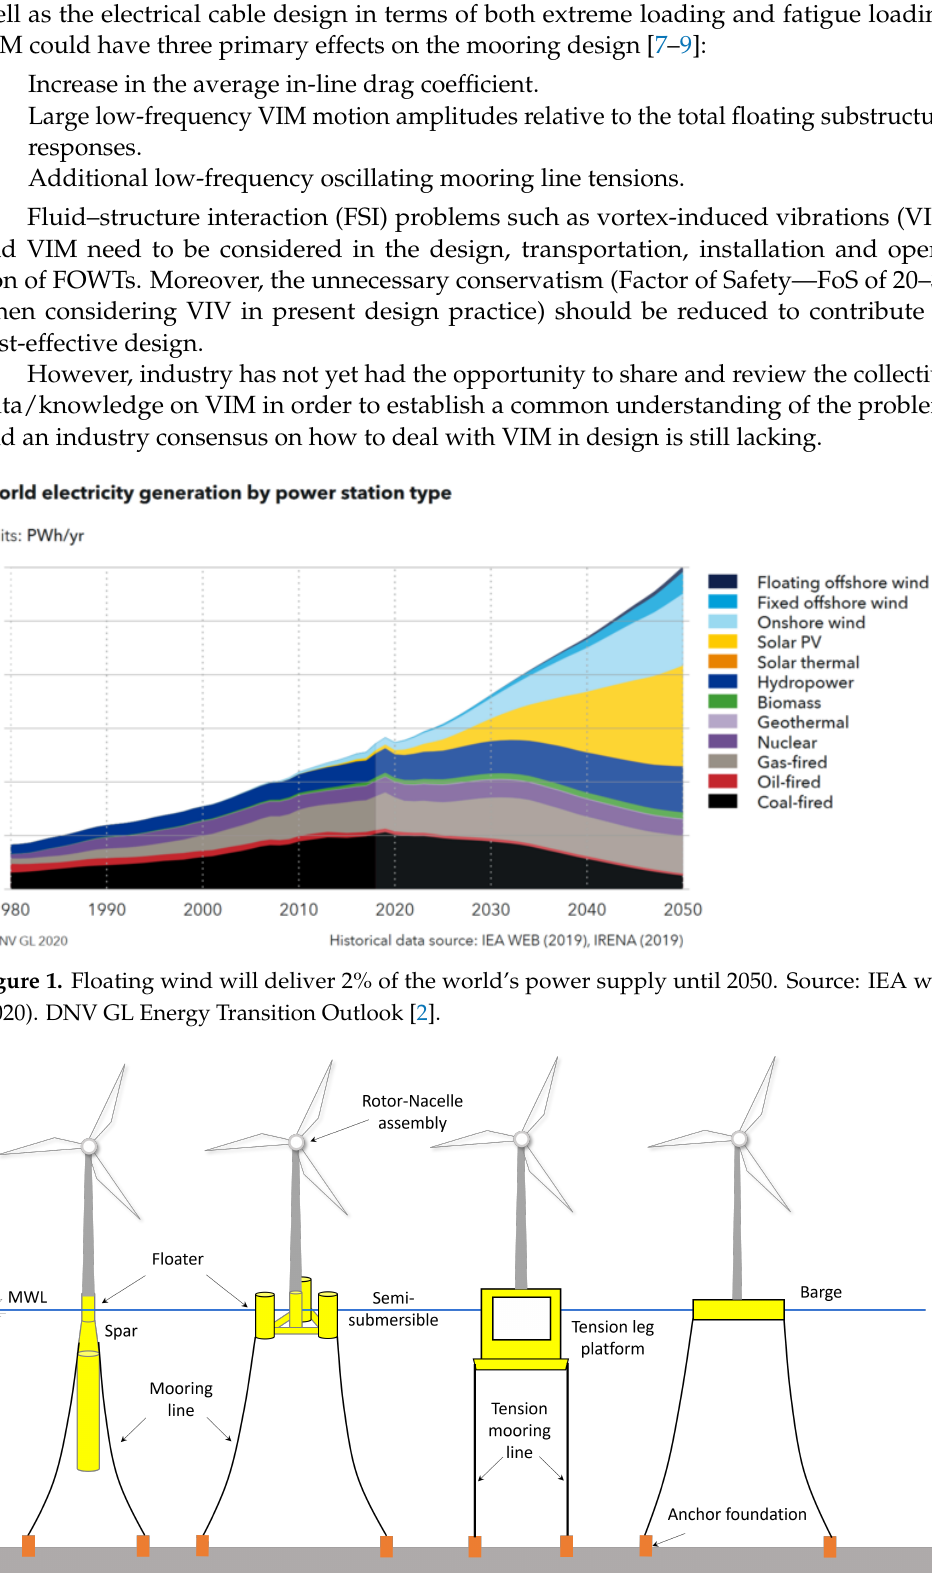
Figure 2. Examples of typical floating offshore wind turbines, sketch inspired by drawing of